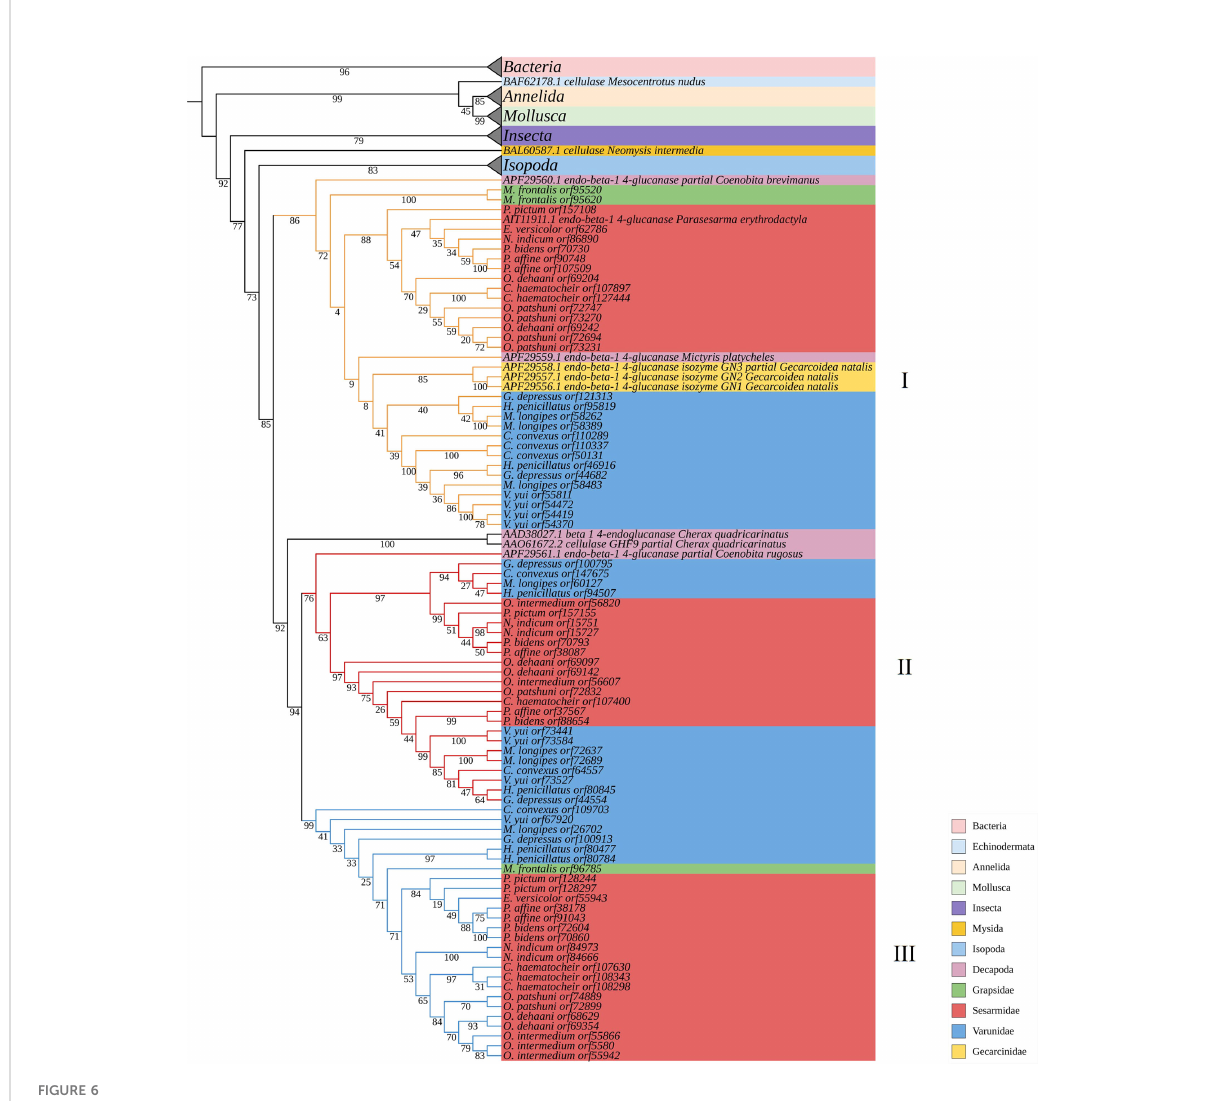
FIGURE 6 Phylogenetic tree of